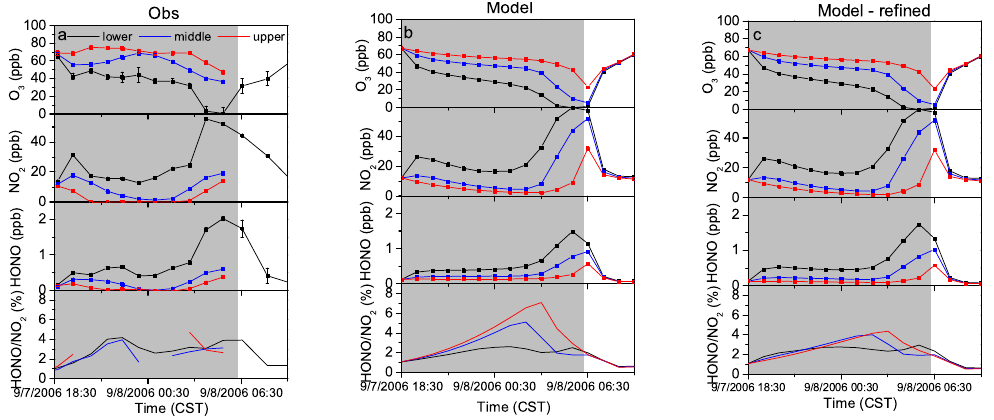
Fig. 5. Comparison of HONO, NO 2 , O 3 mixing ratios and HONO to NO 2 ratios between observations (left) and model results (middle and right) on 7–8 September 2006. (Mixing ratios at lower, middle and upper altitudes are plotted in black, blue and red respectively.) See the Supplement for expanded version of figure.